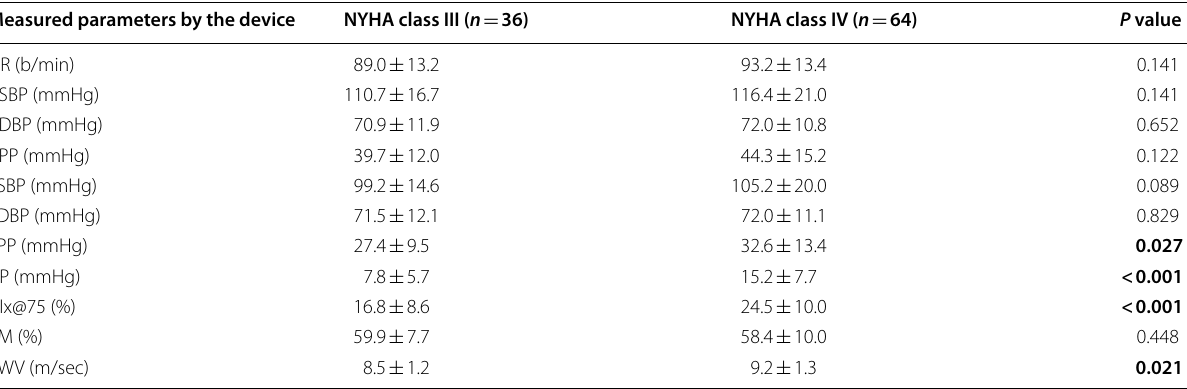
Table 3 Comparison between baseline PWA in patients with NYHA class III and those with NYHA class IV Heart